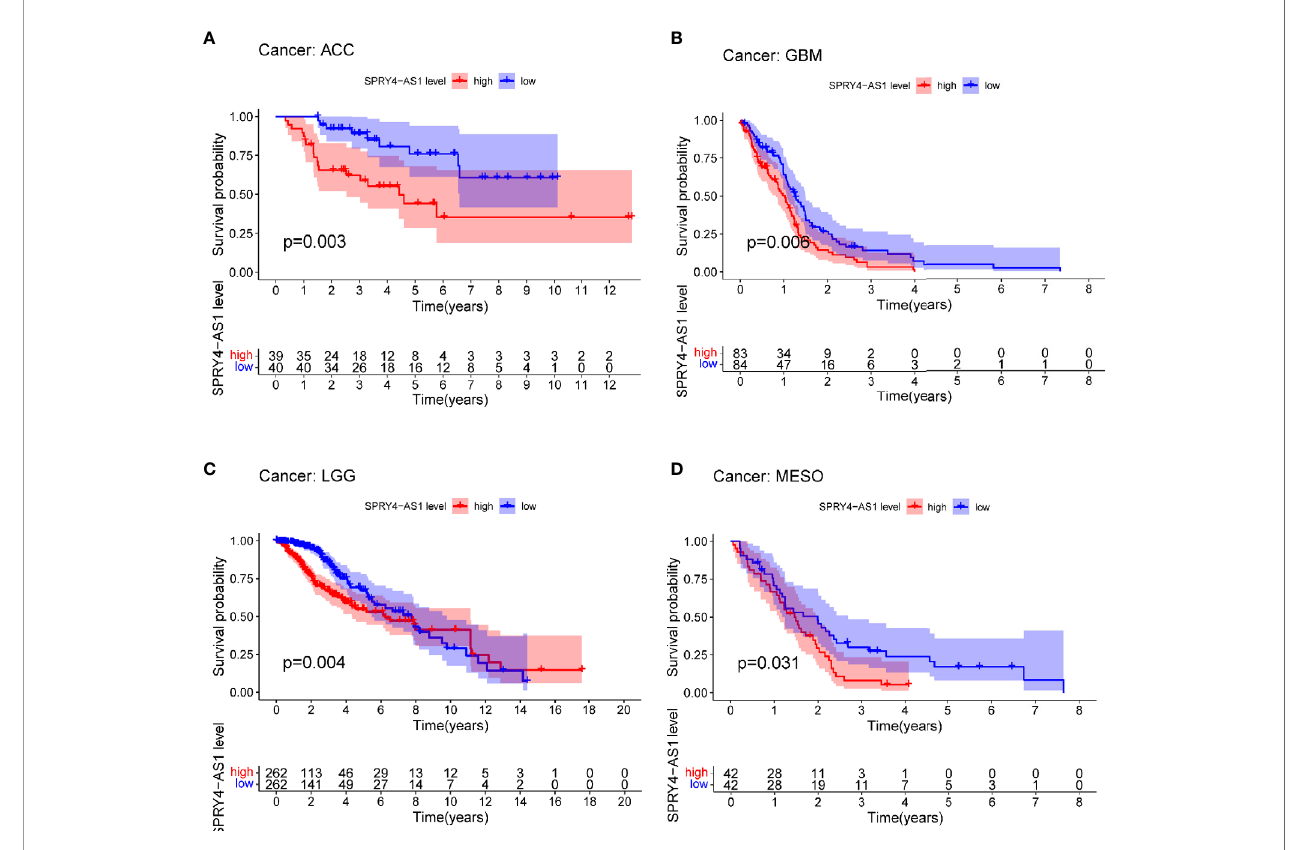
FIGURE 5 | Survival curves for SPRY4 antisense RNA 1 (SPRY4-AS1) in pan-cancer, including ACC (A) , GBM (B) , LGG (C) , MESO (D)